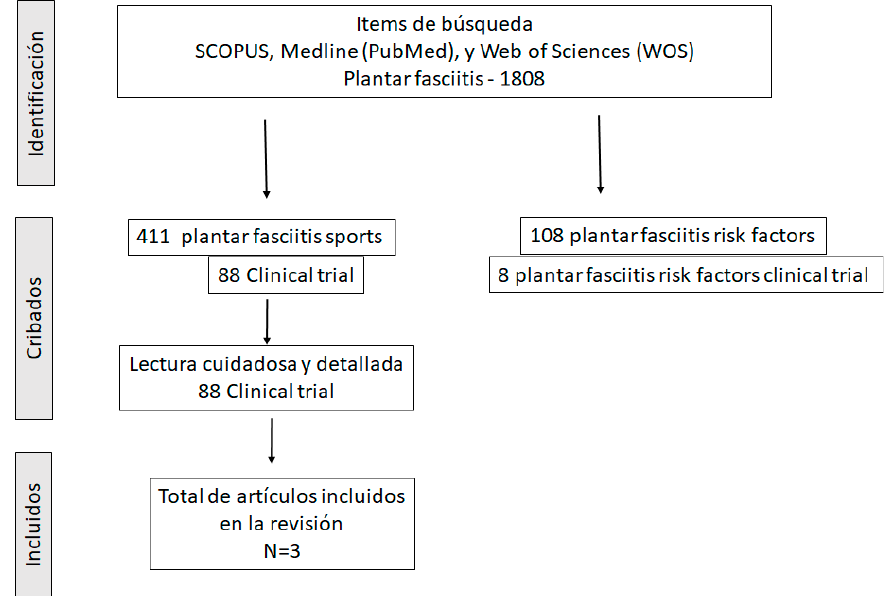
Figure 2. Studies selected for developing the systematic review of plantar fasciitis in soccer